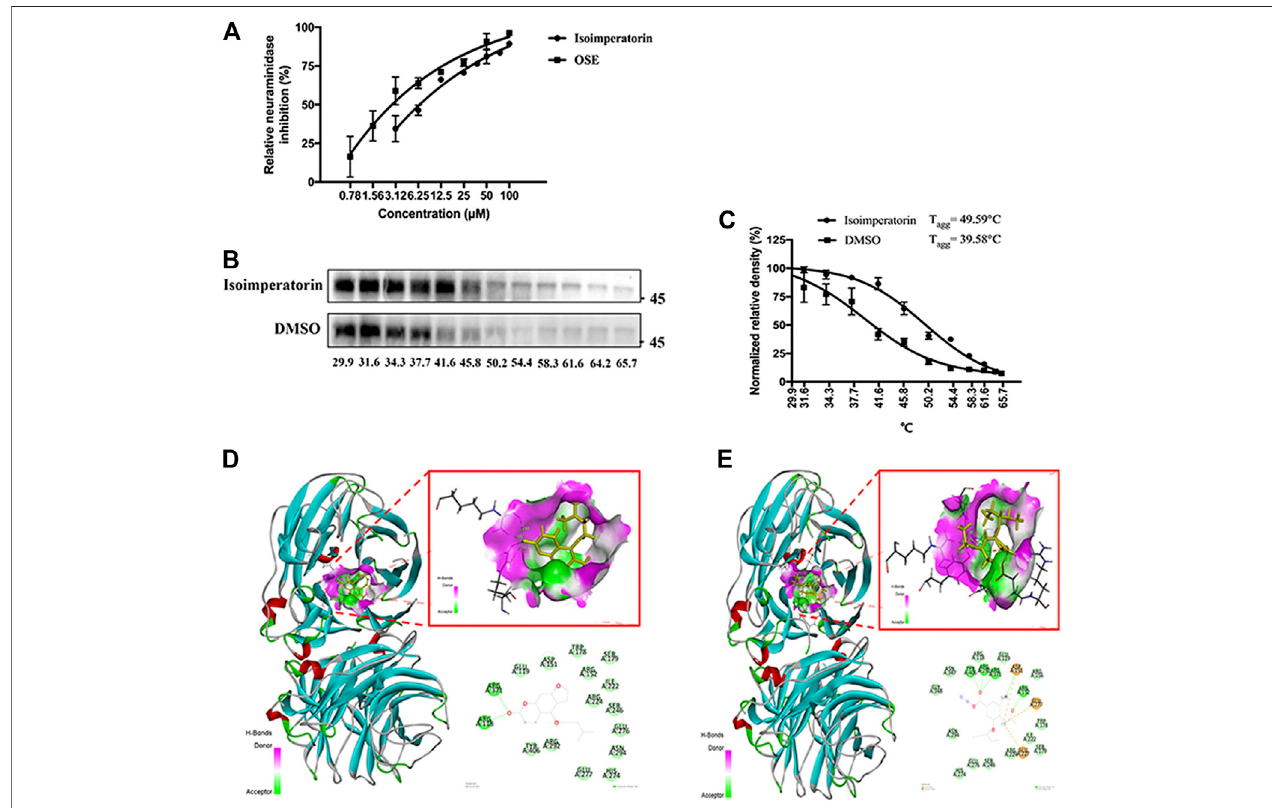
FIGURE 6 | Isoimperatorin inhibits in fl uenza by targeting NA. (A) The inhibitory effect of isoimperatorin on the NA of H1N1 A/PR/8/34 in fl uenza virus was detected by ELISA. Oseltamivirservedas apositivecontrol inthe NA inhibition test. (B) Western blotting showing the H1N1(A/PR/8/34) NA CETSA binding assayin the presence or absence of 50 μ M isoimperatorin at different temperatures. (C) The NA band intensities in the CETSA were quanti fi ed. (D – E) The predicted binding models (3D and 2D) between neuraminidase and compounds. Data are representative of three independent experiments (mean ± SEM).